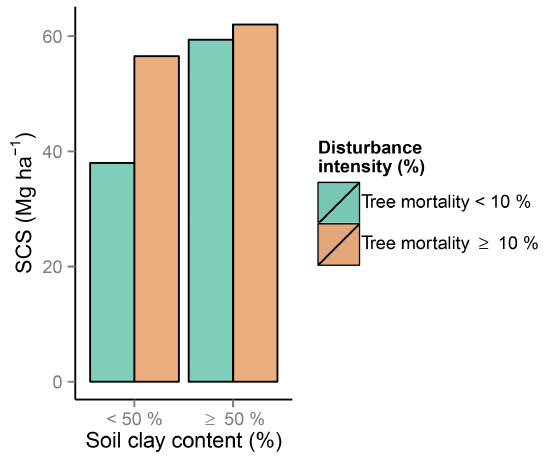
Figure 5. Soil carbon stock (SCS) at sites with different soil clay content and tree mortality